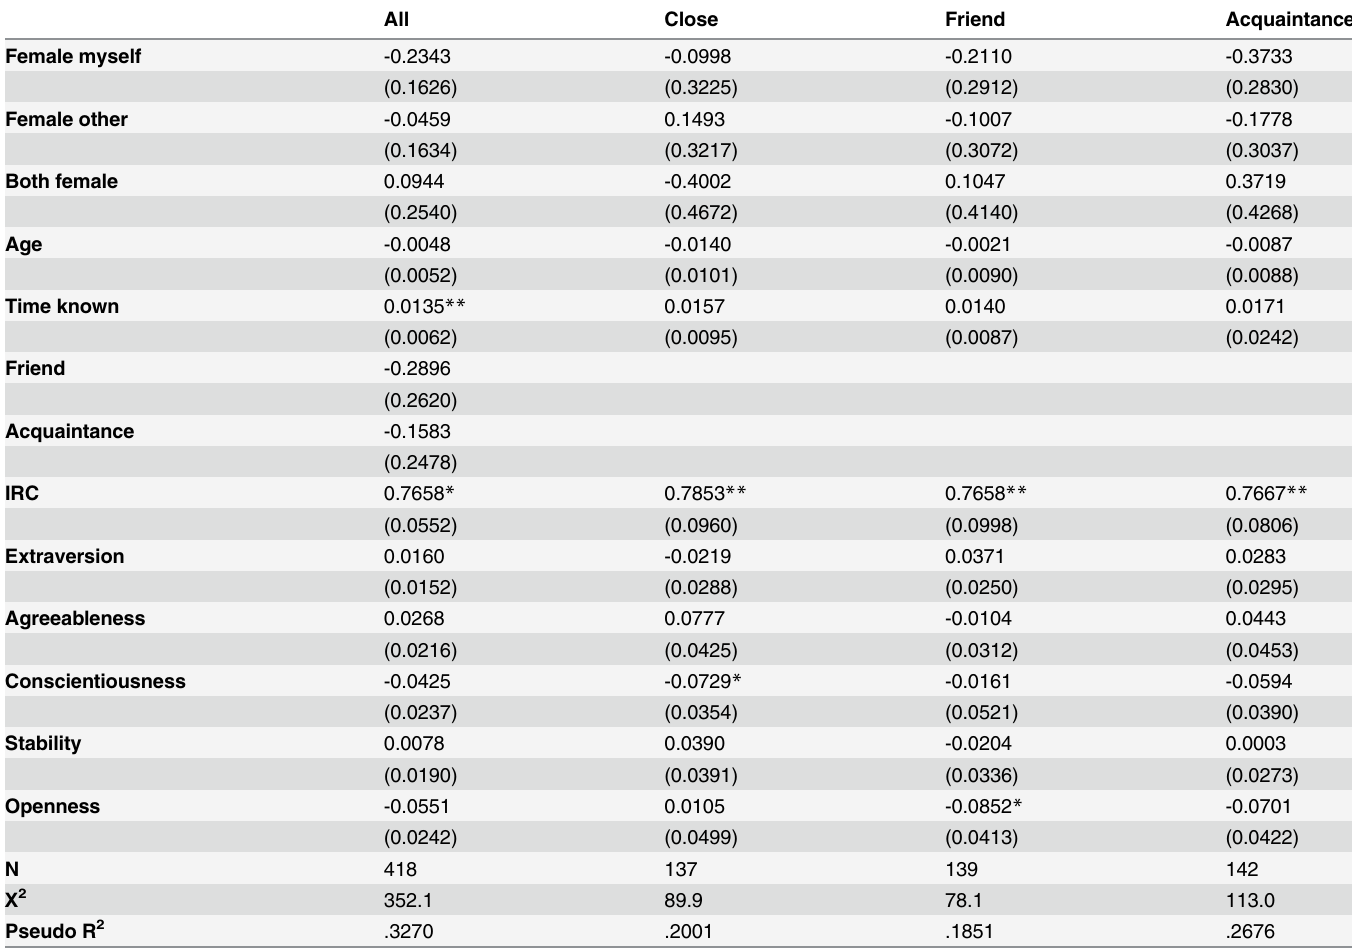
Table 5. Explaining IOS scores in Study 3 with socio-demographics, IRC, and Personality.